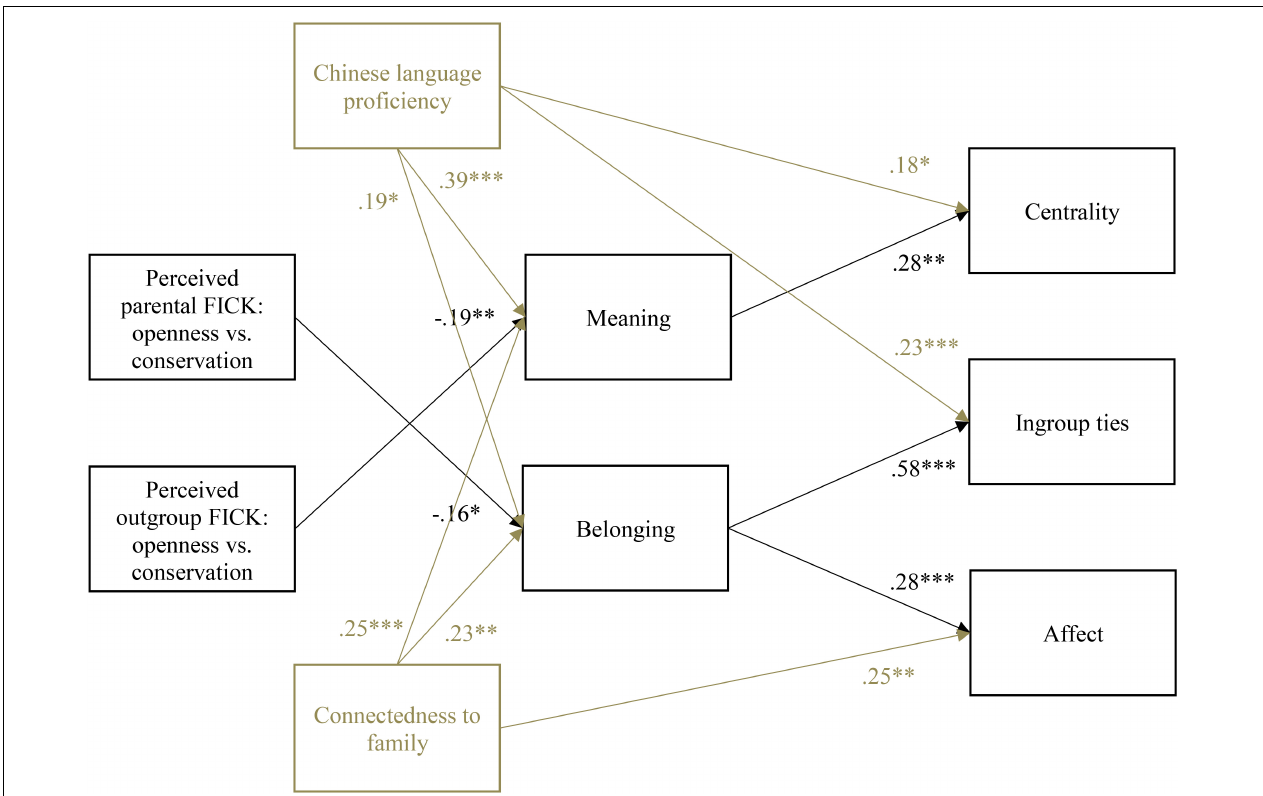
FIGURE 5 | The path model with perceived parental and outgroup FICK in openness to change versus conservation as predictors and meaning and belonging motives as mediators, while Chinese language proficiency and connectedness to family were controlled for (Study 2). χ 2 (14) = 13.47, p = 0.49, CFI = 1.00, TLI = 1.00, RMSEA = 0.00, 90% CI [0.00, 0.08], SRMR = 0.03. FICK, fit in cultural knowledge. Numbers represent standardized regression coefficients. ∗ p < 0.05, ∗∗ p < 0.01, ∗∗∗ p <